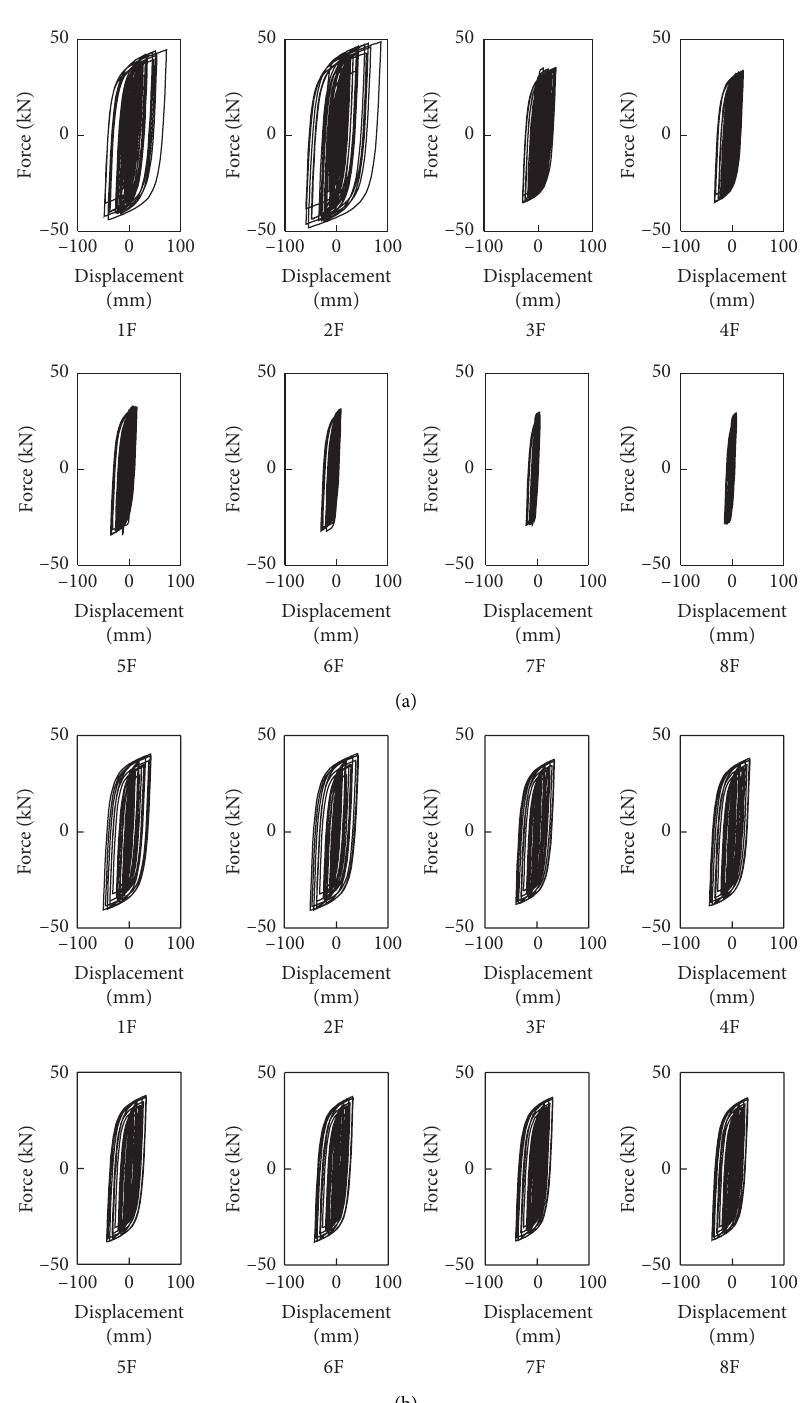
Figure 12: Hysteresis responses of the USDs at different storeys of PRCFCP-USD and PRCFCP-USD-RW under GM9. (a) PRCFCP-USD. (b)